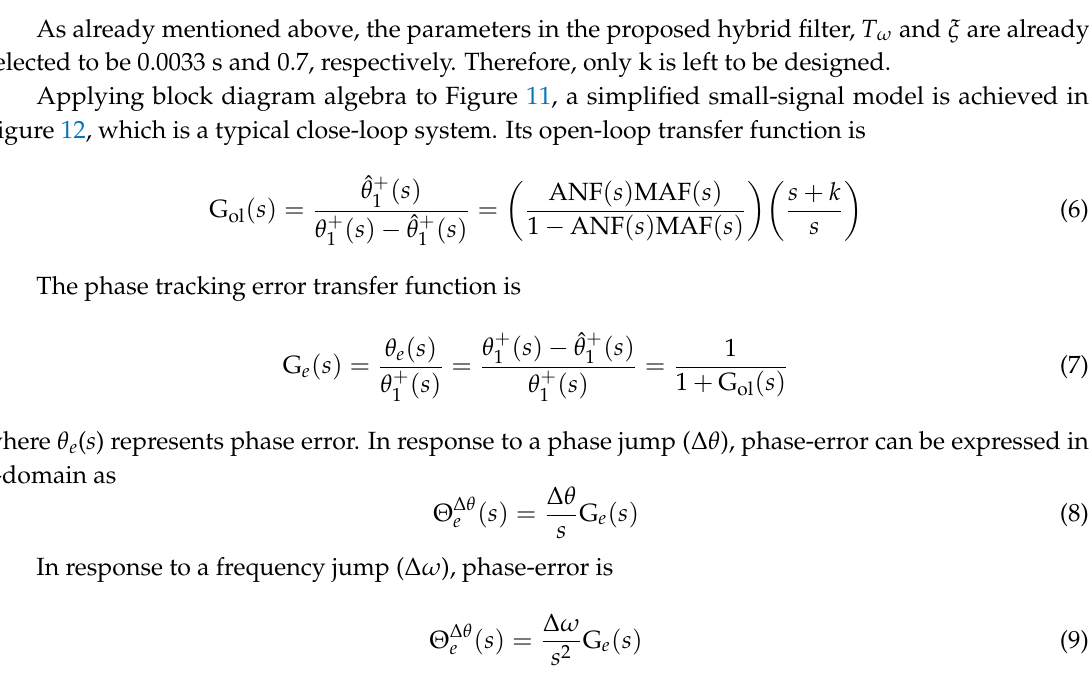
Figure 11. Small-signal model of the proposed PLL.